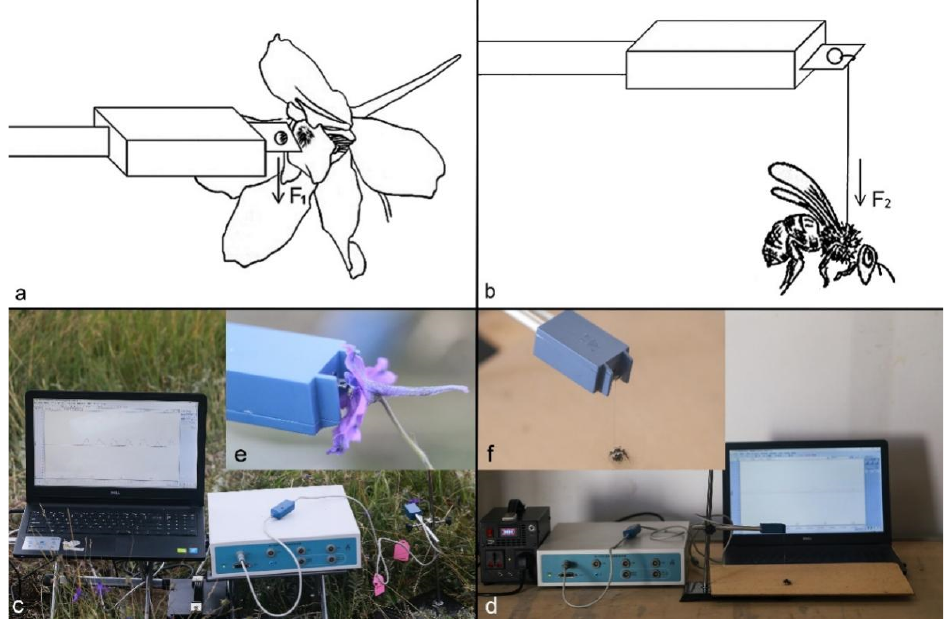
Figure 9. The strength of the staminodes (( a ). F 1 ) and the visitors (( b ). F 2 ) of D. caeruleum was measured by biological tension sensor. ( a ), schematic showing how the sensor was used to measure strength of a flower. ( b ), schematic showing how the sensor was used to measure strength of a bee. ( c ), the apparatus constructed to measure operative strength in flowers. ( d ), the apparatus constructed to measure operative strength in bees. ( e ), detail showing the flowers are handled to measure operative strength. ( f ), detail showing how the sensor is constructed to measure the strength exerted by visitors.